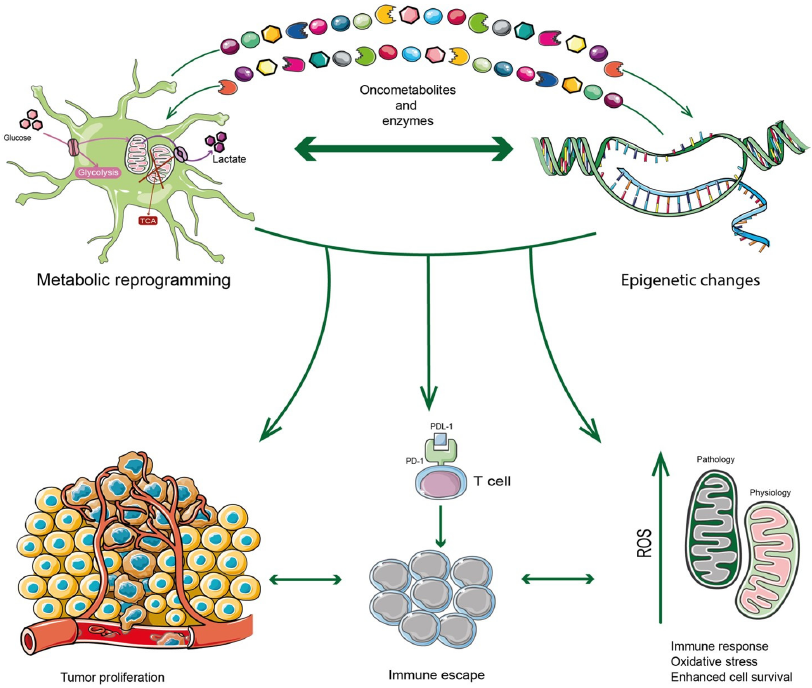
Figure 1. GBM tumor cells are highly inclined to find the metabolic adaptation to survive in hostile conditions including attacks by the immune system. In this regard, their metabolic reprogramming is induced by epigenetic changes that determine the transcription of enzymes or factors belonging to several metabolic pathways. At the same time, enzymes or metabolites can also trigger epigenetic changes. The crosstalk between metabolism and epigenetics can be considered a bridge that leads to immunosuppression mechanisms, generating GBM tumor progression in a complex TME characterized by oxidative stress as well.